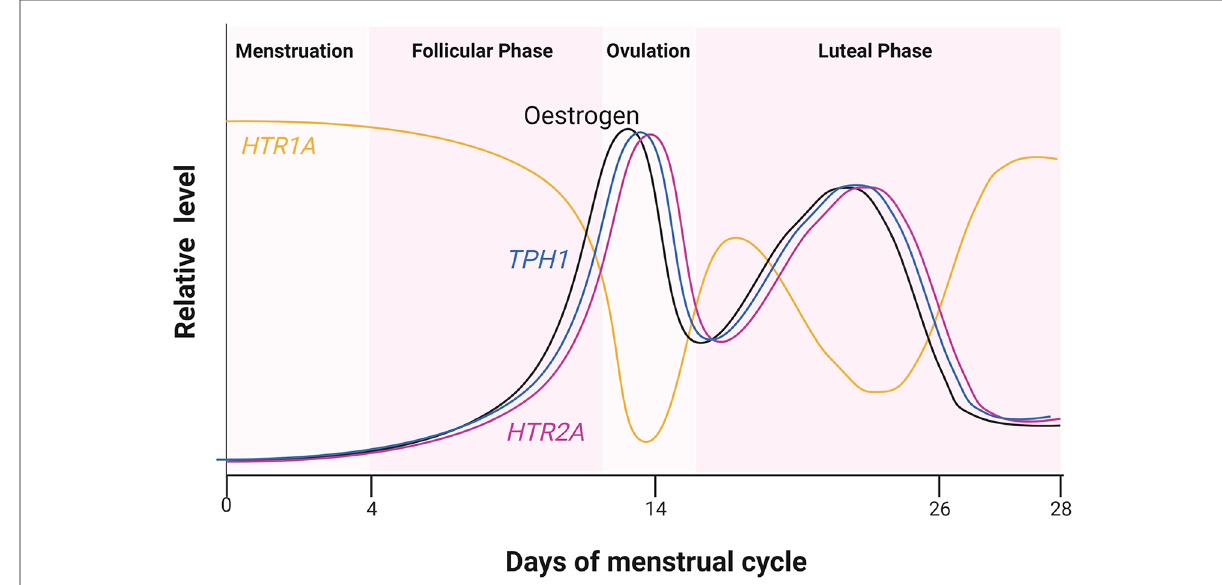
FIGURE 2 Relative hormone level during the four estrus phases. Cycling of oestrogen levels during the menstrual cycle was compared to the expression of HTR2A and HTR1A encoding 5-HT2a and 5-HT1a receptors, respectively. Oestrogen receptor (ER) also regulates TPH1 encoding one of the serotonin biosynthesis genes. Created with BioRender.com.